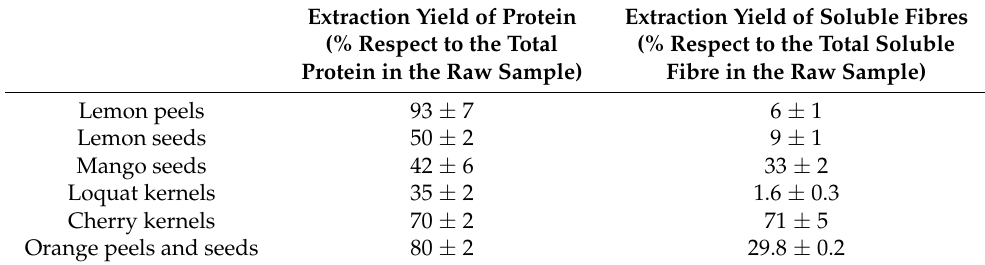
Table 2. Extraction yields, expressed in percentage, of soluble fibres (determined from total monosac- charide composition) and solubilized protein (determined by Kjeldahl method on the supernatant). Values are mean ± SD of replicates of independent